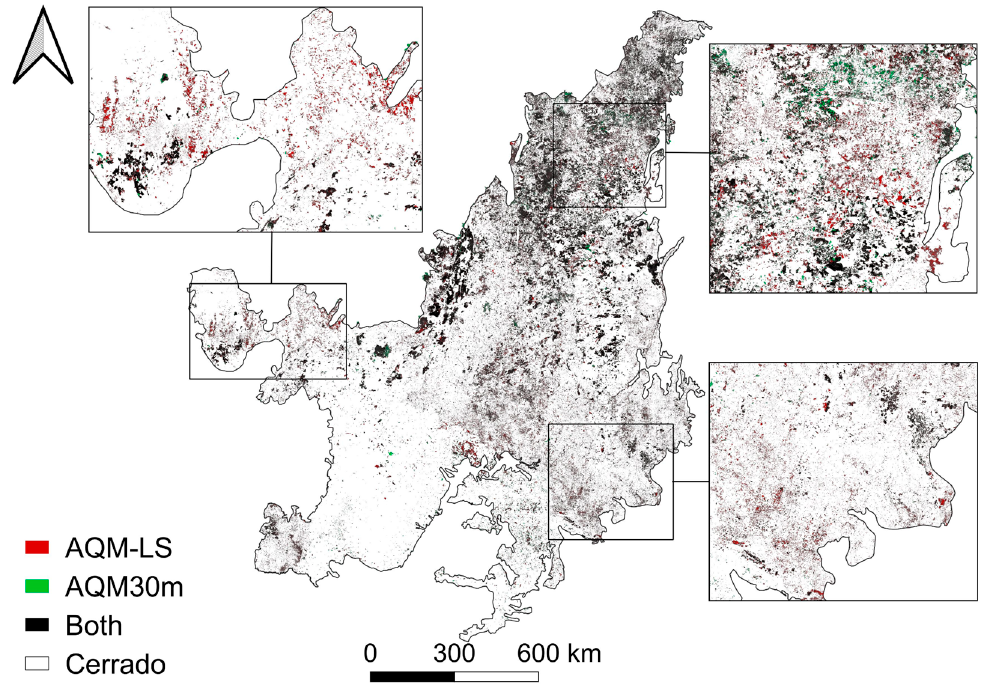
Figure 5. Spatial distribution of burned area detected by AQM-LS (red), AQM30m (green), and by both products (namely, AQM-LS and AQM30m, black) over Cerrado for 2015; insets show spatial detail of BA classification for areas in Northern, Southwestern, and Southeastern Cerrado.